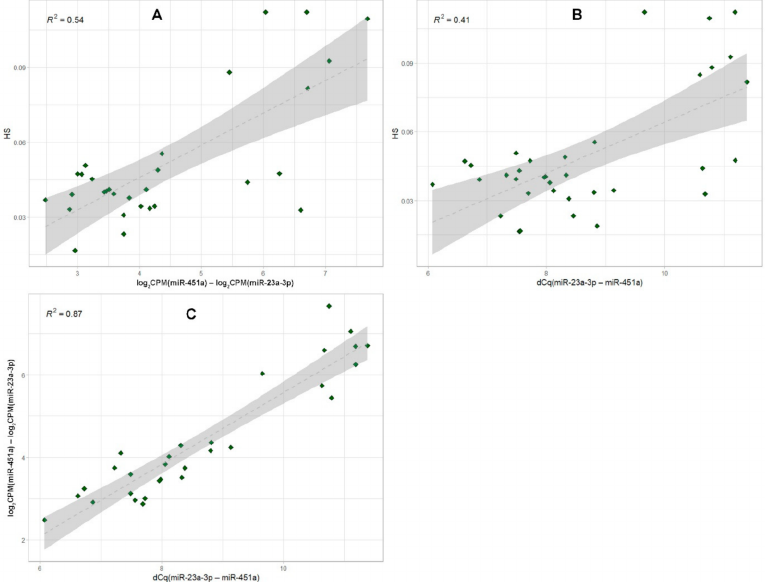
Figure 14. Correlation plots for the hemolysis assessment using different methods. ( A ) Spectrophotometric hemolysis score (HS) vs. sequencing-based miRNA hemolysis ratio between miR-23a-3p and